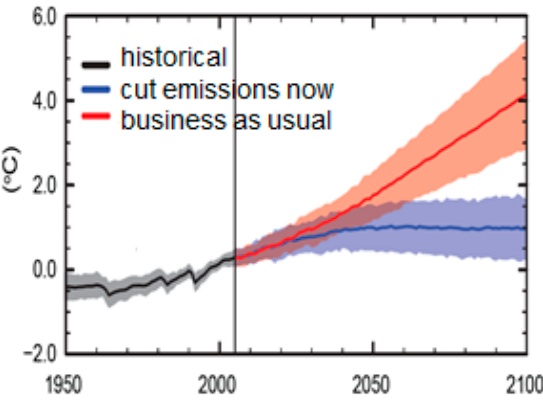
Figure 1. Taken from [1], a plot highlighting variance/uncertainty in the forecasts of temperature rise (shaded) as a result of a specific continued business as usual emission scenario (red) and a net-zero emission from now.